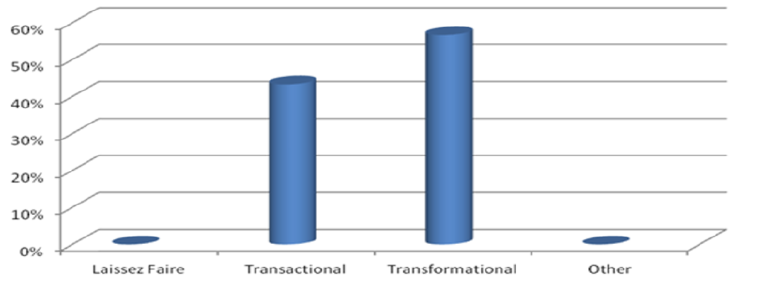
Figure 1: Leadership styles at NSSA; Source: Primary data.